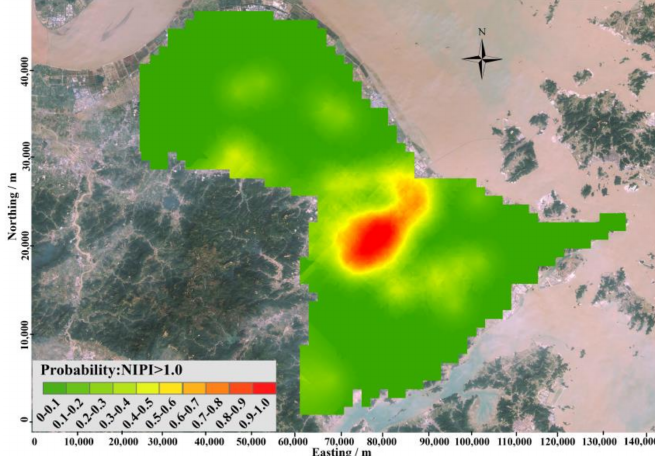
Figure 3. Spatial distribution of the probability of Nemerow integrated pollution index (NIPI) > 1.0.